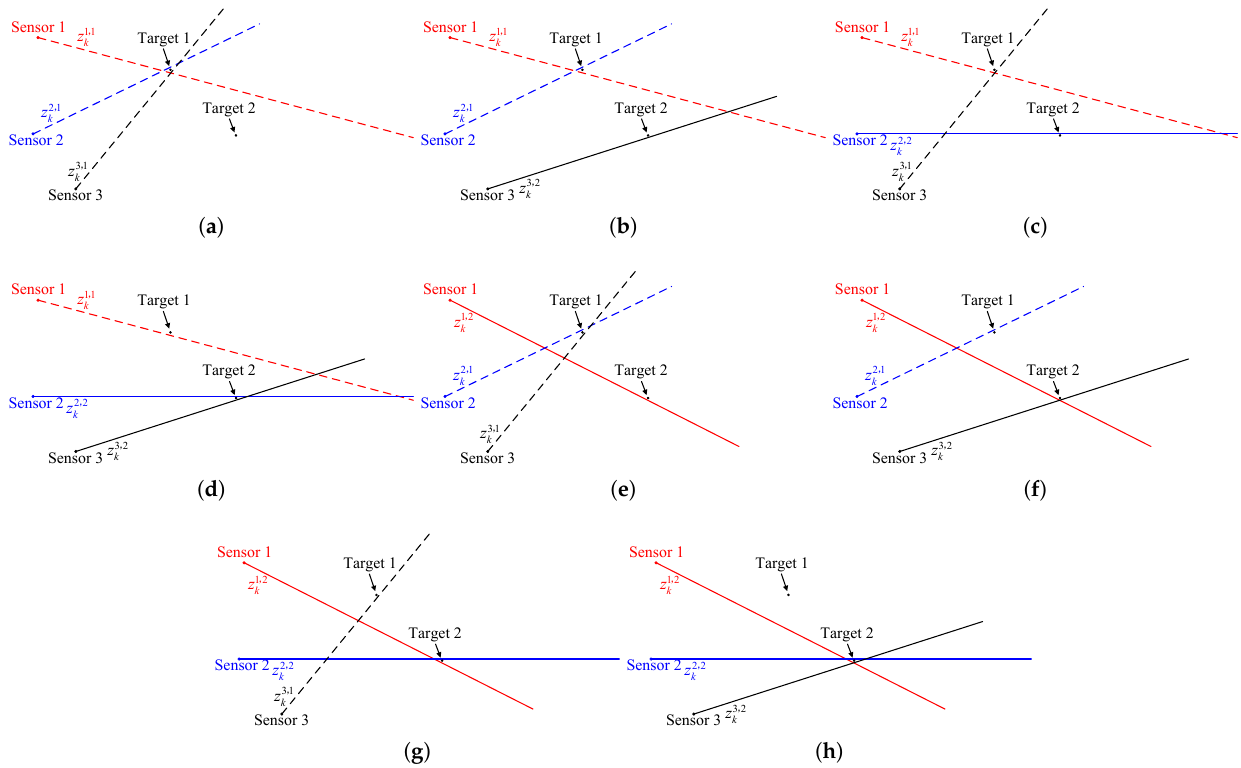
Figure 4. Geometric relationship between sensors and S-tuples of measurements ( a ) Z 111 ( c ) Z 121 . ( d ) Z 122 . ( e ) Z 211 . ( f ) Z 212 . ( g ) Z 221 . ( h ) Z 222 k k k k k k